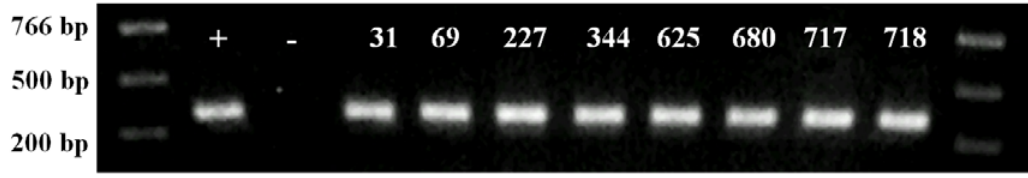
Figure 4. PCR screening of plantlets regenerated from hygromycin resistant T using hpt -specific primers. (+) positive control, plasmid DNA; ( − ) negative control, wild-type cv. Nipponbare DNA. Plant identification numbers 31, 69, 227, 344, 625, 680, 717, and 718 show PCR products consistent with the expected 362 bp control fragment. PCR products were separated on a 1.2% agarose